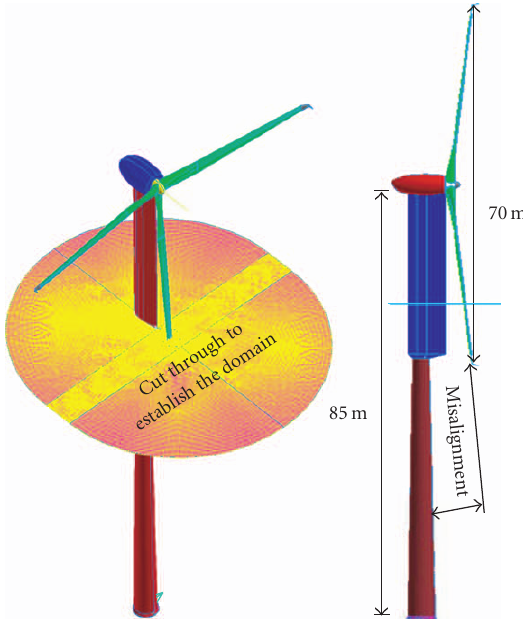
Figure 1: The 2D computational domain showing the rotor and